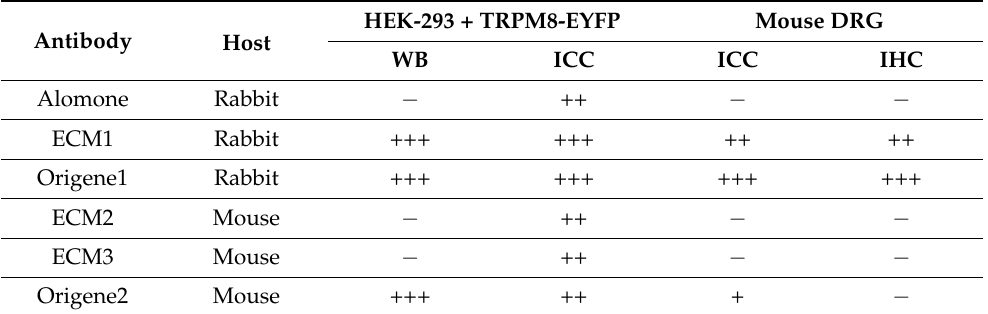
Table 1. Antibody performance with the different techniques used in this study. − poor, + regular, ++ good, +++